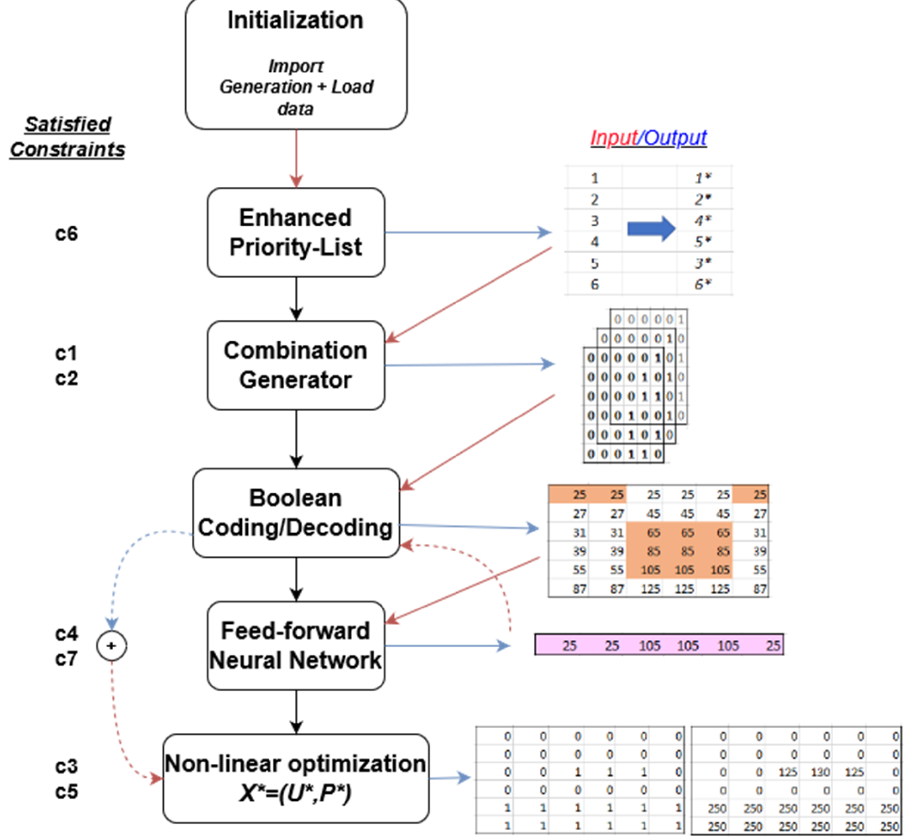
Figure 2. Flow diagram of the comprehensive BM optimization paradigm.